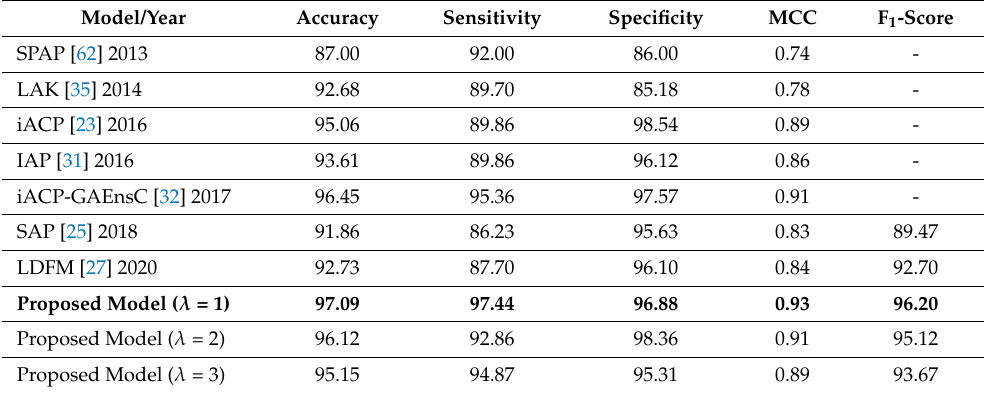
Table 5. Performance comparison of the proposed model with SOTA methods using PSD 1 dataset, where the best result is highlighted in